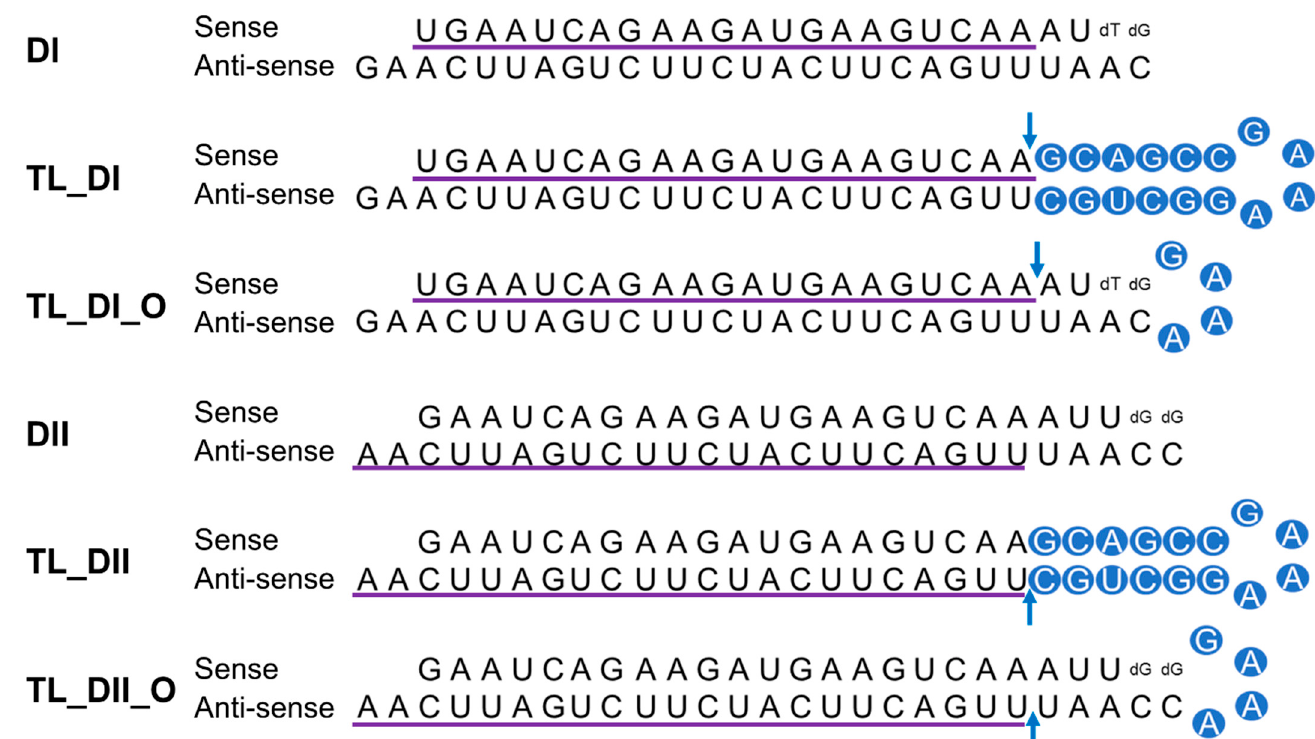
Figure 4. Structure of hnRNPH1-targeted DsiRNAs and tetra-looped DsiRNAs. We designed two DsiRNAs targeting hnRNPH1, DsiRNA I (DI) and DsiRNA II (DII), then added a 5 (cid:48) -GAAA-3 (cid:48) tetra- loop (TL) into each DsiRNA and synthesized different stem structures for each, one with a GC-rich stem (TL_DI and TL_DII) and another with the original stem (TL_DI_O and TL_DII_O), which corresponds to the hnRNPH1 target gene. TL_DI has a 21-mer sense strand and a 38-mer antisense strand, with a GC-rich stem and 5 (cid:48) -GAAA-3 (cid:48) tetra-loop (represented with blue circles). TL_DI_O has the same sequence as DI, with a 5 (cid:48) -GAAA-3 (cid:48) tetra-loop sequence (blue circles). TL_DII has a 22-mer antisense strand and 36-mer sense strand, with a GC-rich stem and 5 (cid:48) -GAAA-3 (cid:48) tetra-loop (blue circles). TL_DII_O has the same sequence as DII, with a 5 (cid:48) -GAAA-3 (cid:48) tetra-loop sequence (blue circles). The detailed sequences are listed in Table 1. Ribonucleotides are shown in upper case and deoxyribonucleotides as dN. The purple underlined sequence shows the active strand. The blue arrow indicates the nick between